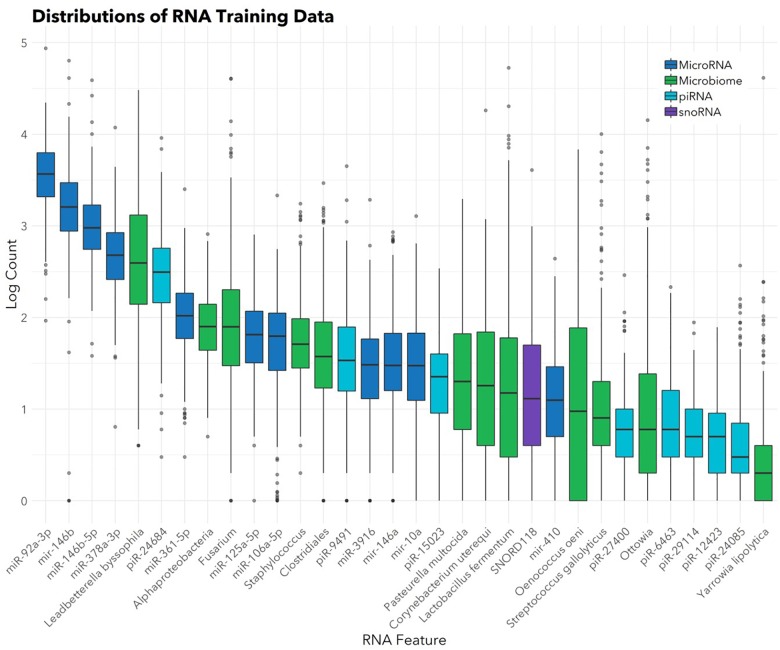
Abundances of 32 salivary RNAs selected for the diagnostic panel. Box and whisker plots show distributions (in the training set; n = 372) of the 32 RNAs included in the panel. Color indicates RNA category. Box hinges indicate 25th, 50th, and 75th percentiles. Upper whiskers extend to the largest value up to 1.5∗IQR, where IQR is inter-quartile range between the 75th and 25th percentiles. Lower whiskers extend to the smallest value down to 1.5∗IQR. Outliers beyond the whiskers are plotted individually.